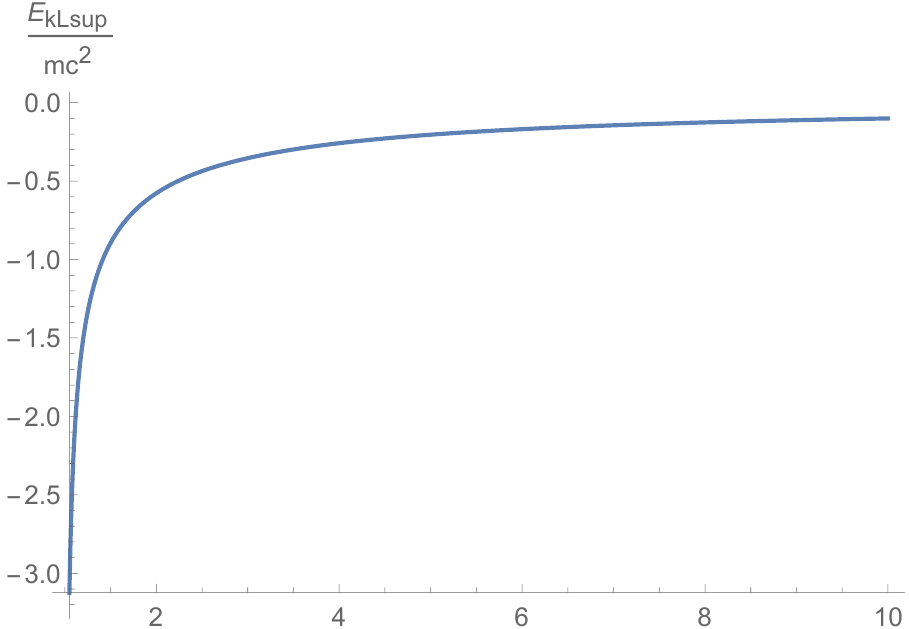
Figure 9. Kinetic energy for Lorentzian particles of superluminal